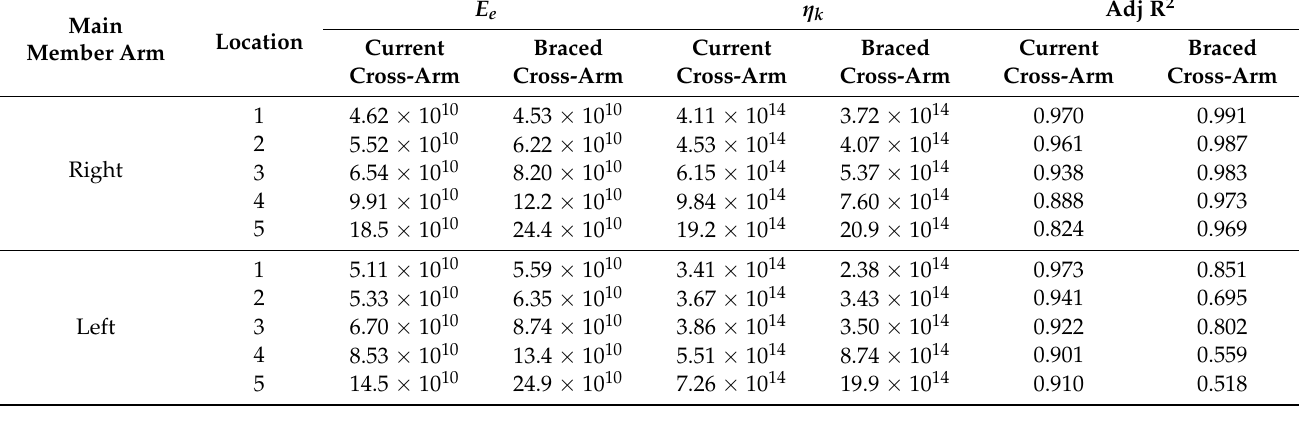
Table 4. Average parameters obtained from Burger model for both current and braced wooden cross-arms.